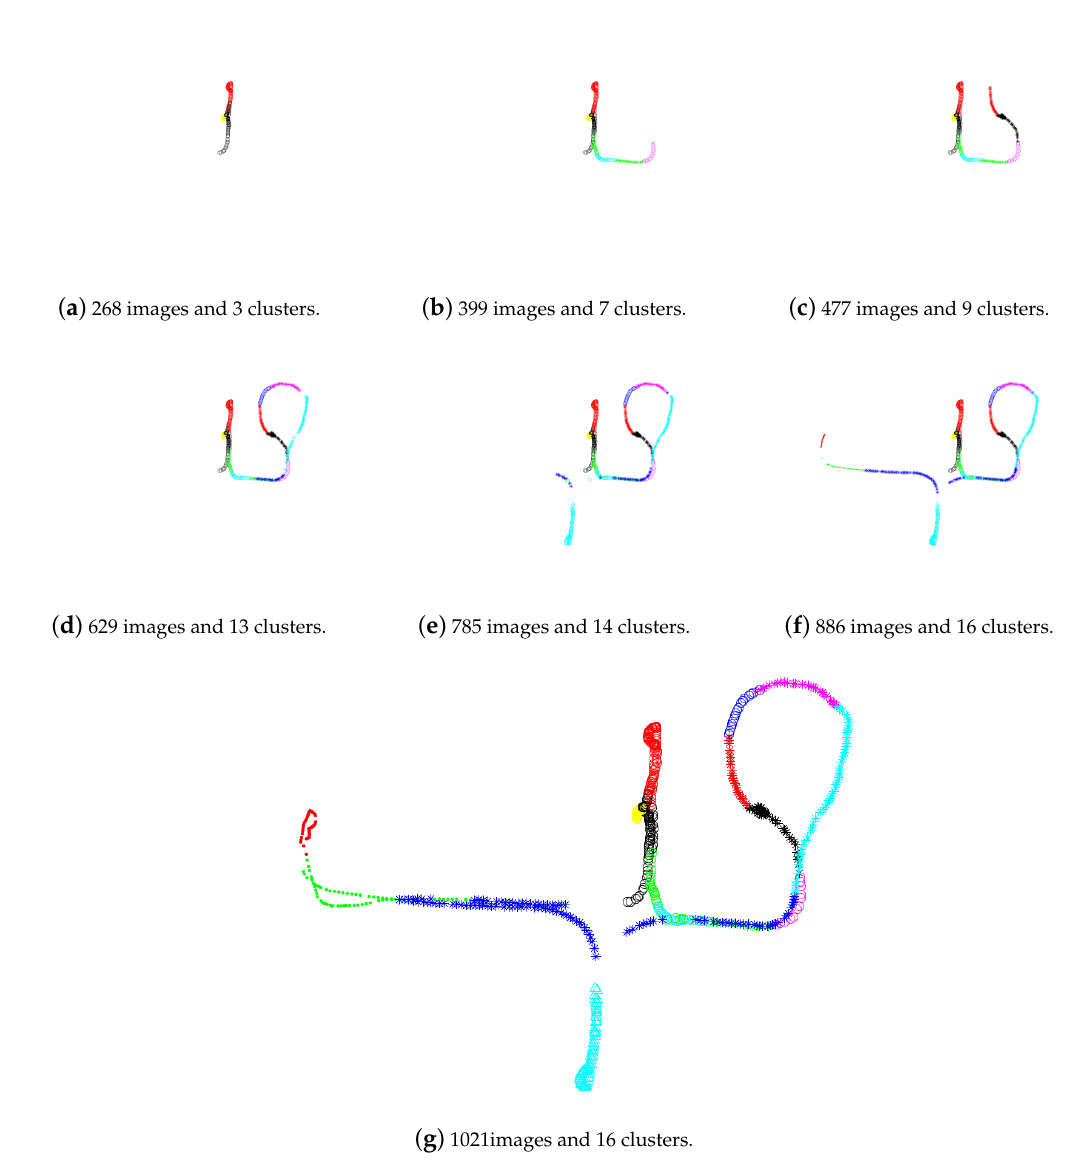
Figure 14. Maps obtained during the process using HOG y = 1.25, Ω = 1.85 with the Saarbrücken dataset. The subfigures show different steps of the process. In the end, the process detects 16 nodes and the final average silhouette is